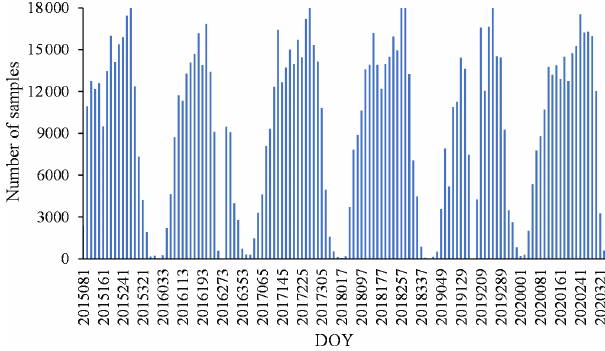
ables from MOD13A2 and MOD15A2H are the best com- posite within 16 and 8 d, respectively. To overcome the